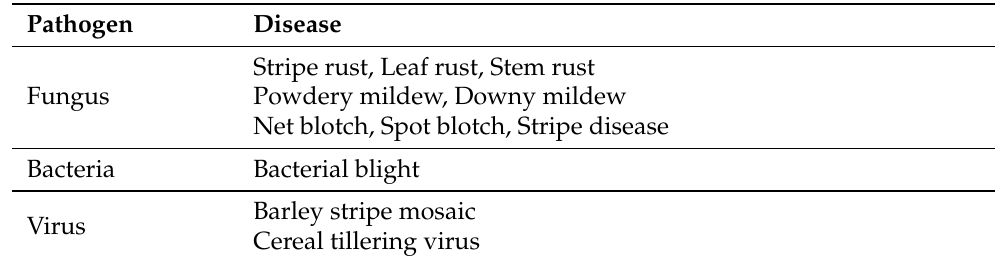
Table 5. Some Barley disease types and causing pathogens [19,20,40].